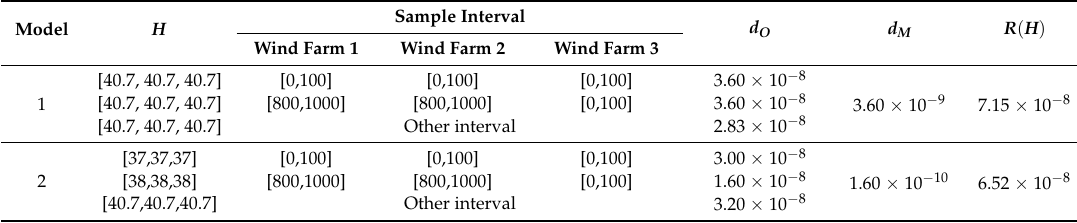
Table 3. Accuracy comparison between AMNKDE and Copula parameter